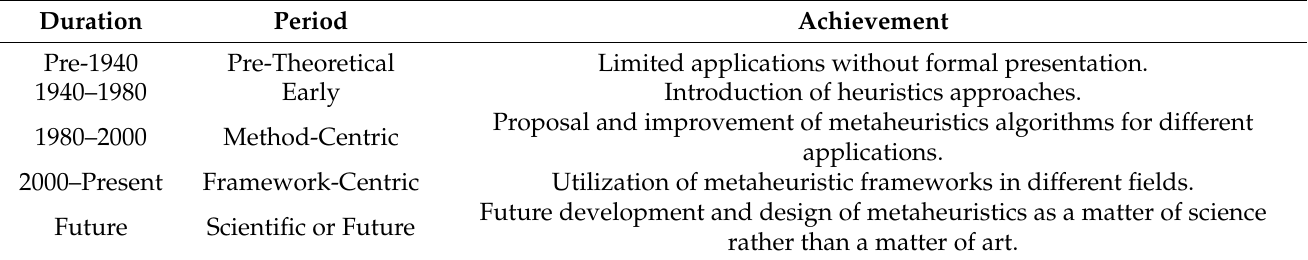
Table 1. Summary of historical time periods for the evolution of metaheuristics